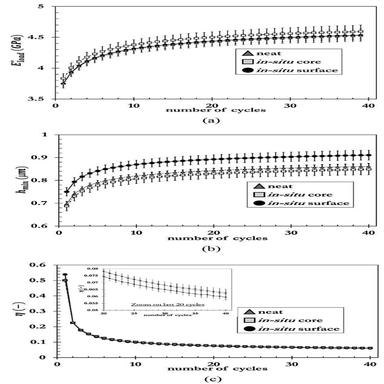
Evolution of (a) instantaneous elastic modulus, (b) residual depth and (c) energy ratio with indentation cycles measured on the neat polymer (Δ) and in core (□) and on the external surface (ο) of the composite.